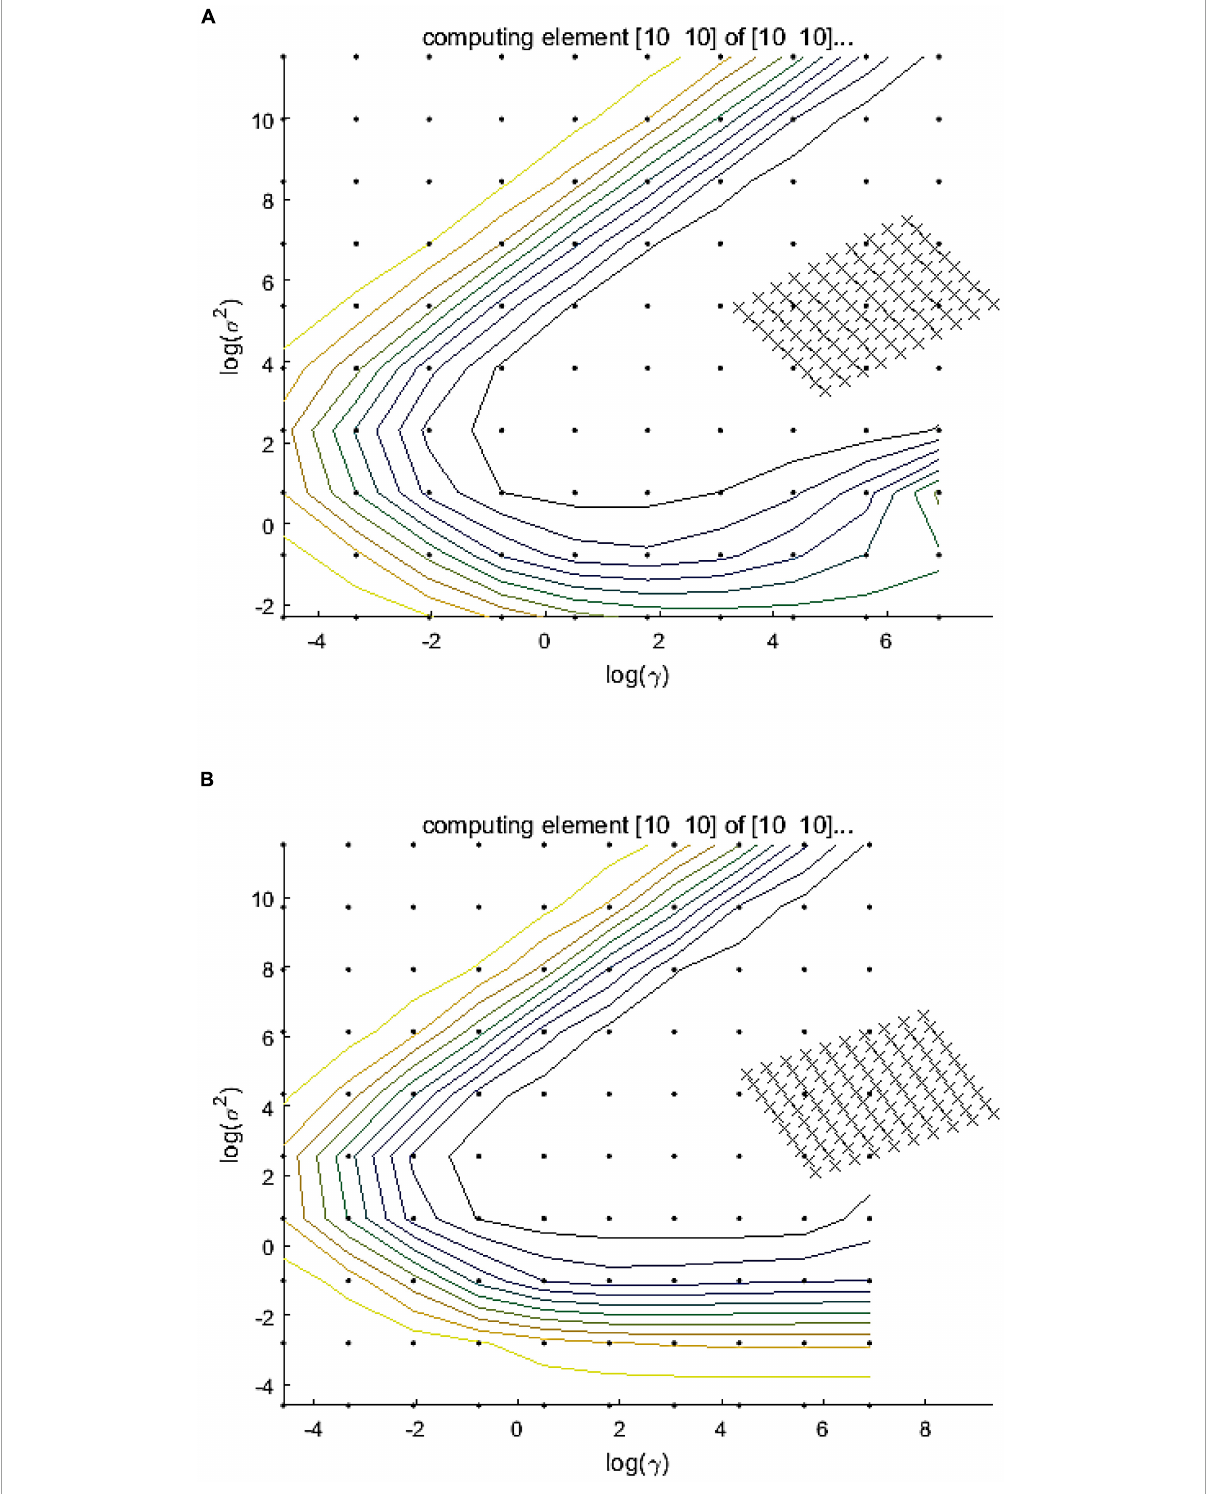
FIGURE4 The LS-SVR models were established to predict the reduction effect of acrylamide, and the model performance including the optimization of γ and δ 2 was investigated when the addition level of flavonoids was (A) in the range of 1–100 µ mol/L (inhibition range) or (B) in the range of 100–10,000 µ mol/L (promotion